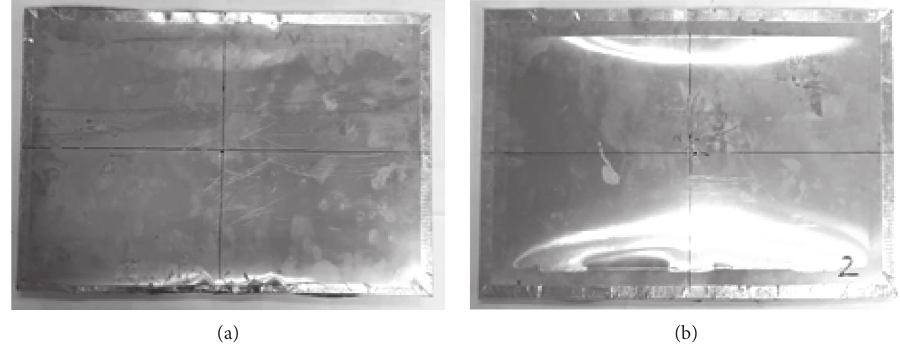
Figure 14: Front view of ST2 deformation. (a) Explosion-facing panel. (b) Explosion-back panel.